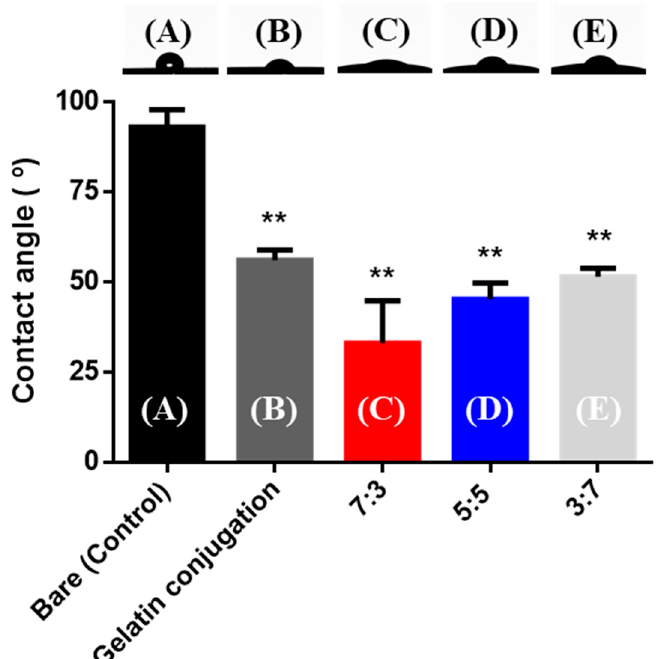
Figure 5. Contact-angle images and values of the modified poly(dimethylsiloxane) (PDMS) surface compared to the bare PDMS surface. ( A ) Bare PDMS; ( B ) Gelatin-conjugated PDMS and hydrogel coated groups with CHO–HA/Gel–NH 2 ( C ) 7:3, ( D ) 5:5, and ( E ) 3:7. (** p < 0.01, Mann–Whitney test, compared to bare PDMS.)